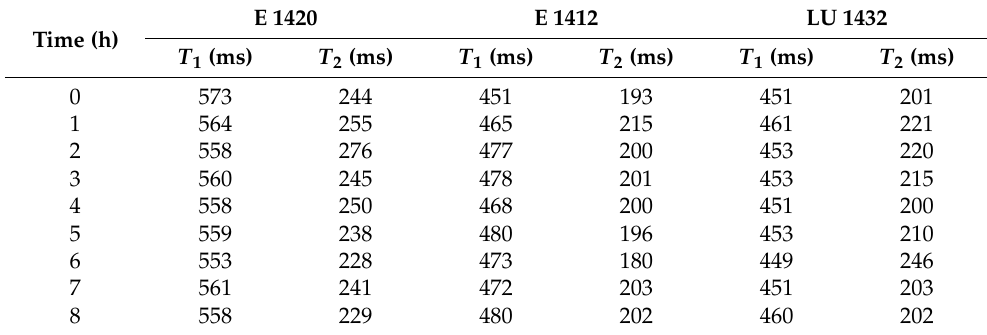
Table 1. Values of spin–lattice ( T 1 ) and spin–spin ( T 2 ) relaxation times in modified potato starch gels. E 1420 E 1412 LU 1432 Time (h) T 1 (ms) T 2 (ms) T 1 (ms) T 2 (ms) T 1 (ms) T 2 (ms) 0 573 244 451 193 451 201